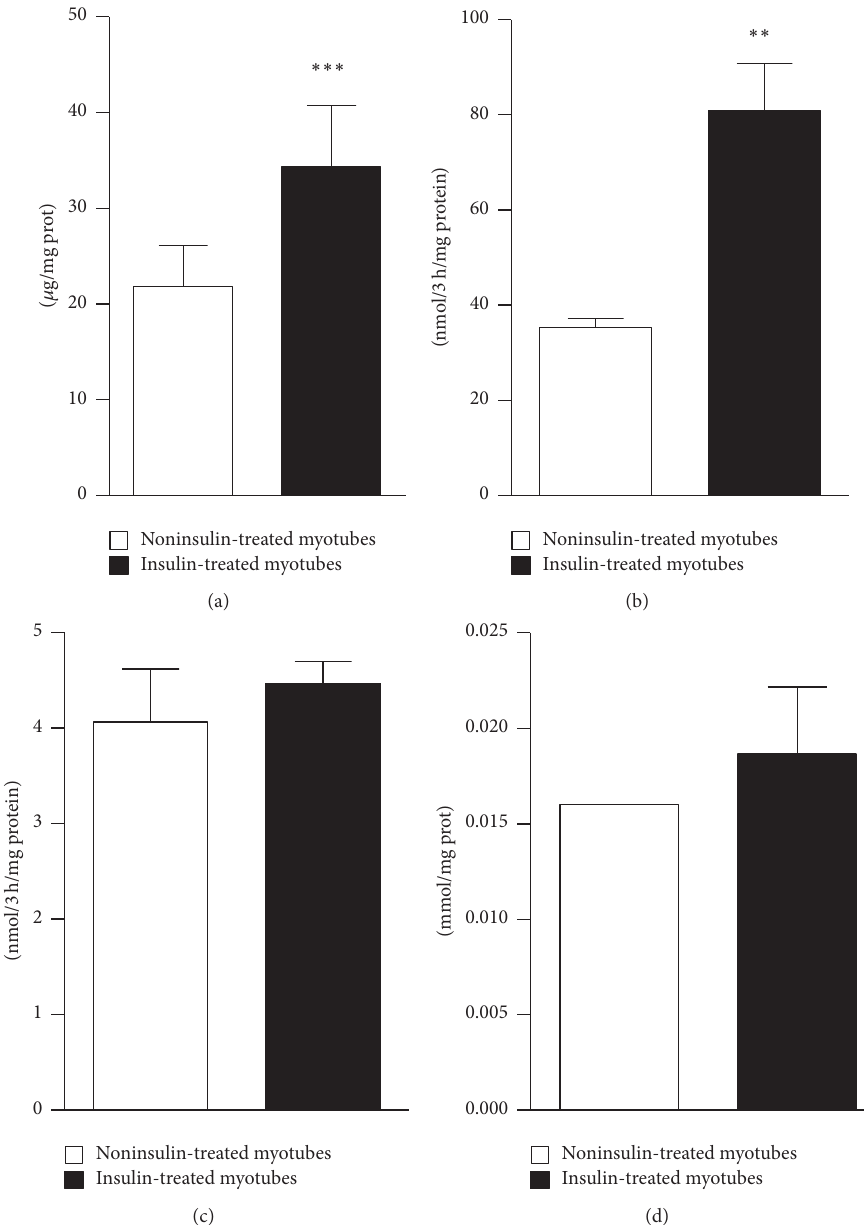
Figure 1: Myotubes metabolic changes in response to insulin. Glycogen content (a) and extracellular lactate content (d) were determined after 24 h with/without 100nmol/L insulin treatment. Glycogen synthesis (b) and glucose oxidation (c) were determined after 3h incubation with D[U- 14 C]glucose with/without 100 nmol/L insulin. Mean ± SEM. ∗∗ 𝑝 < 0.01 and ∗∗∗ 𝑝 < 0.001 , two-tailed t test.